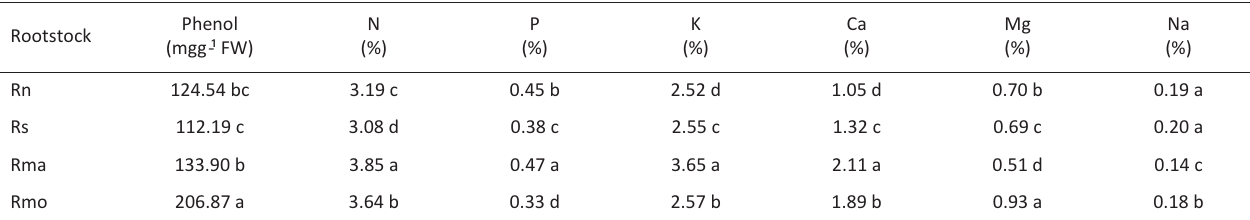
Rn= nongrafted ( Cucumis sativus var. DavosII);